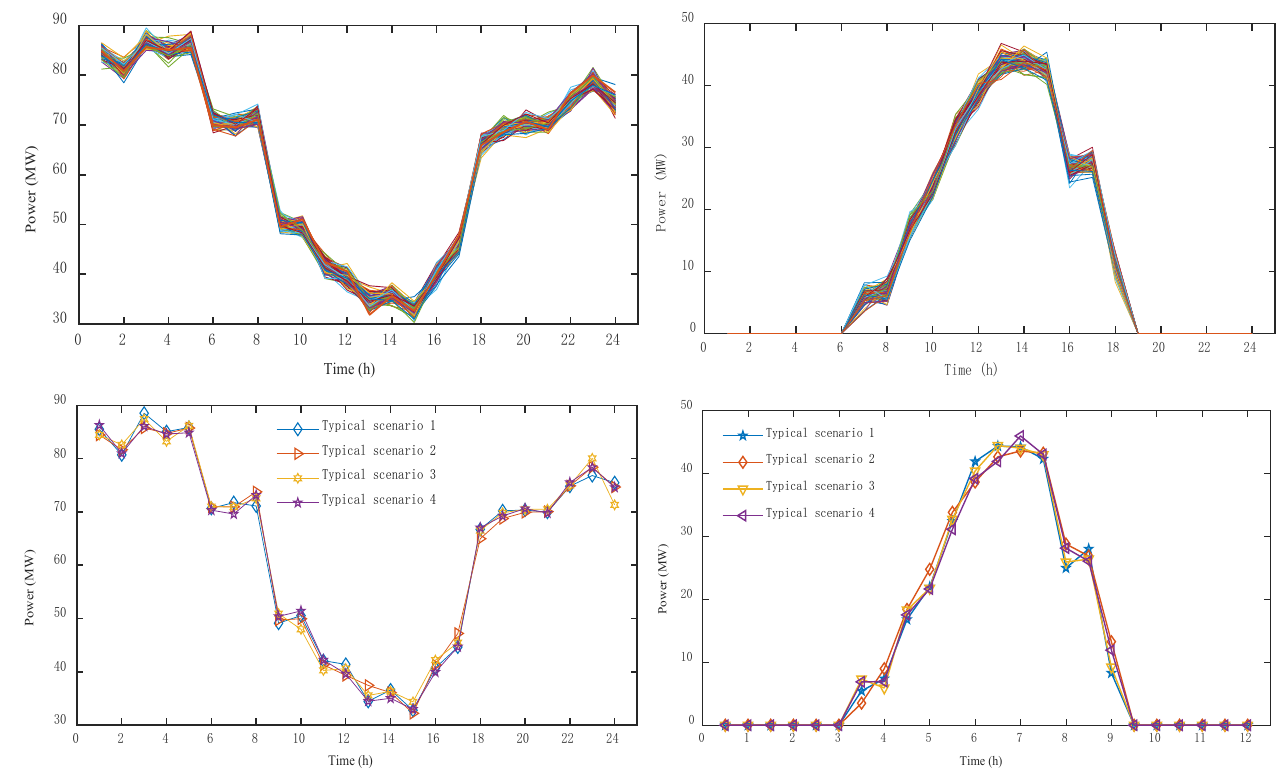
100 Figure 4. Typical forecasted daily load and DNI. 4.2. Analysis of Results of Example 4.2.1. Generation of Typical Combined Scenarios A wind farm and a photovoltaic power station in the Dunhuang area of Gansu Prov- ince were selected as research objects. We used data on the predicted and actual outputs of wind and photovoltaic power on a typical day that were collected every hour. Through